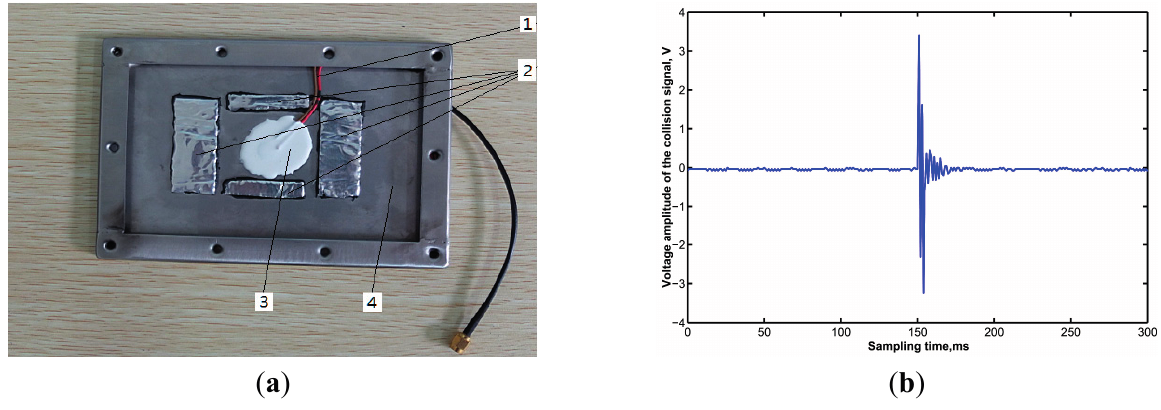
Figure 12. Collision signal waveform when damping layer laying on the optimal position. 1. Signal wire; 2. Viscoelastic material layer; 3. Piezoelectric ceramic; 4. Sensitive